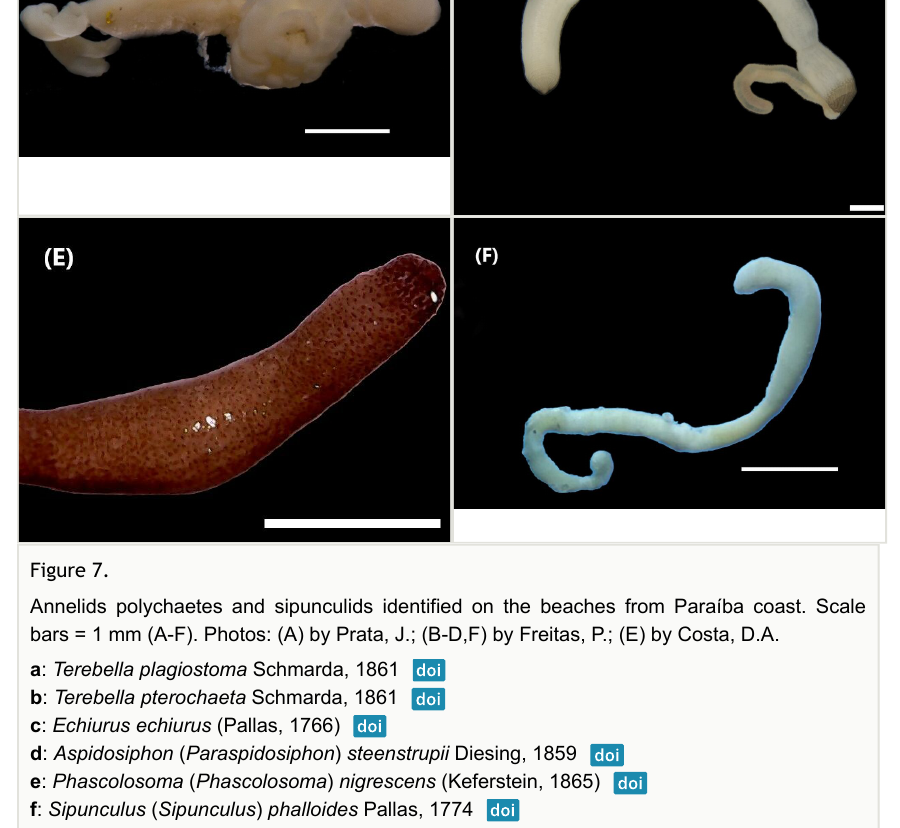
Distribution: Caribbean Sea and Brazilian coast (Paraíba, Sergipe, Rio de Janeiro, São Paulo and Rio Grande do Sul States) (Amaral et al. 2013, Costa et al. 2017, Read and Fauchald 2020}).